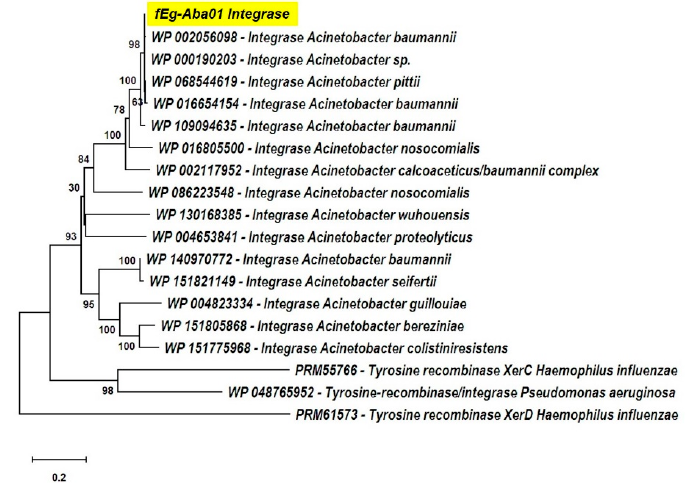
Figure 5. The phylogenetic tree of fEgAb01 integrase with different site-specific Acinetobacter integrases and rooted with the Haemophilus influenza and Pseudomonas aeruginosa integrases. The tree was constructed using the MEGA X neighbor-joining statistical tree analysis method with bootstrapping set to 1000 tree branches are proportional to branch lengths. The branch labels represent bootstrap values. The integrase of fEg.Aba01 is highlighted in yellow.